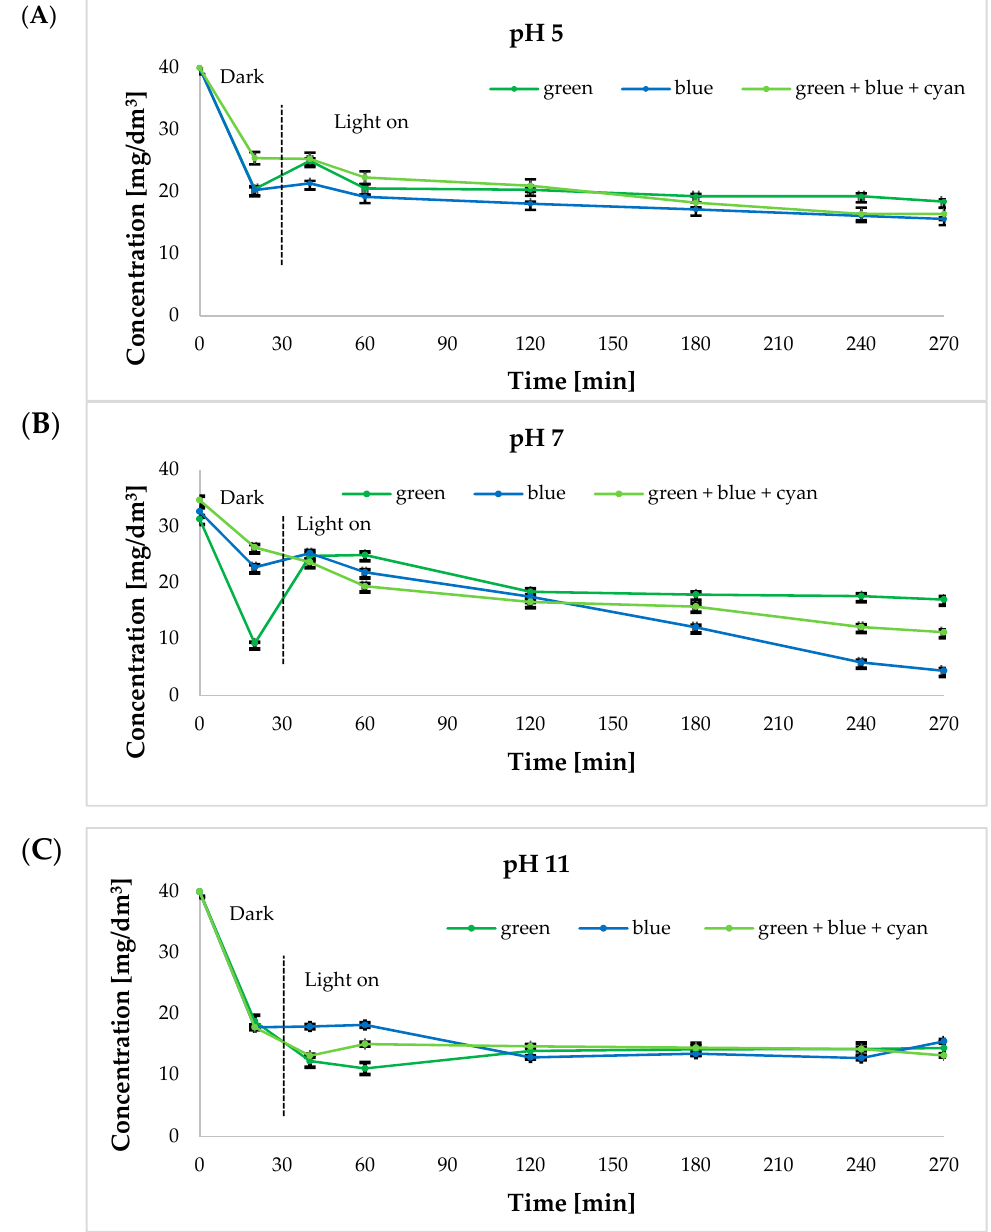
Figure 4. Time dependence of absorbance for 40 mg/dm 3 bisphenol A solutions under green, blue, and green+blue+cyan under light irradiation at 25 ◦ C at different solution pH: ( A ) pH 5; ( B ) pH 7; ( C ) pH 11 in the presence of ruthenium ion-modified biosilica.